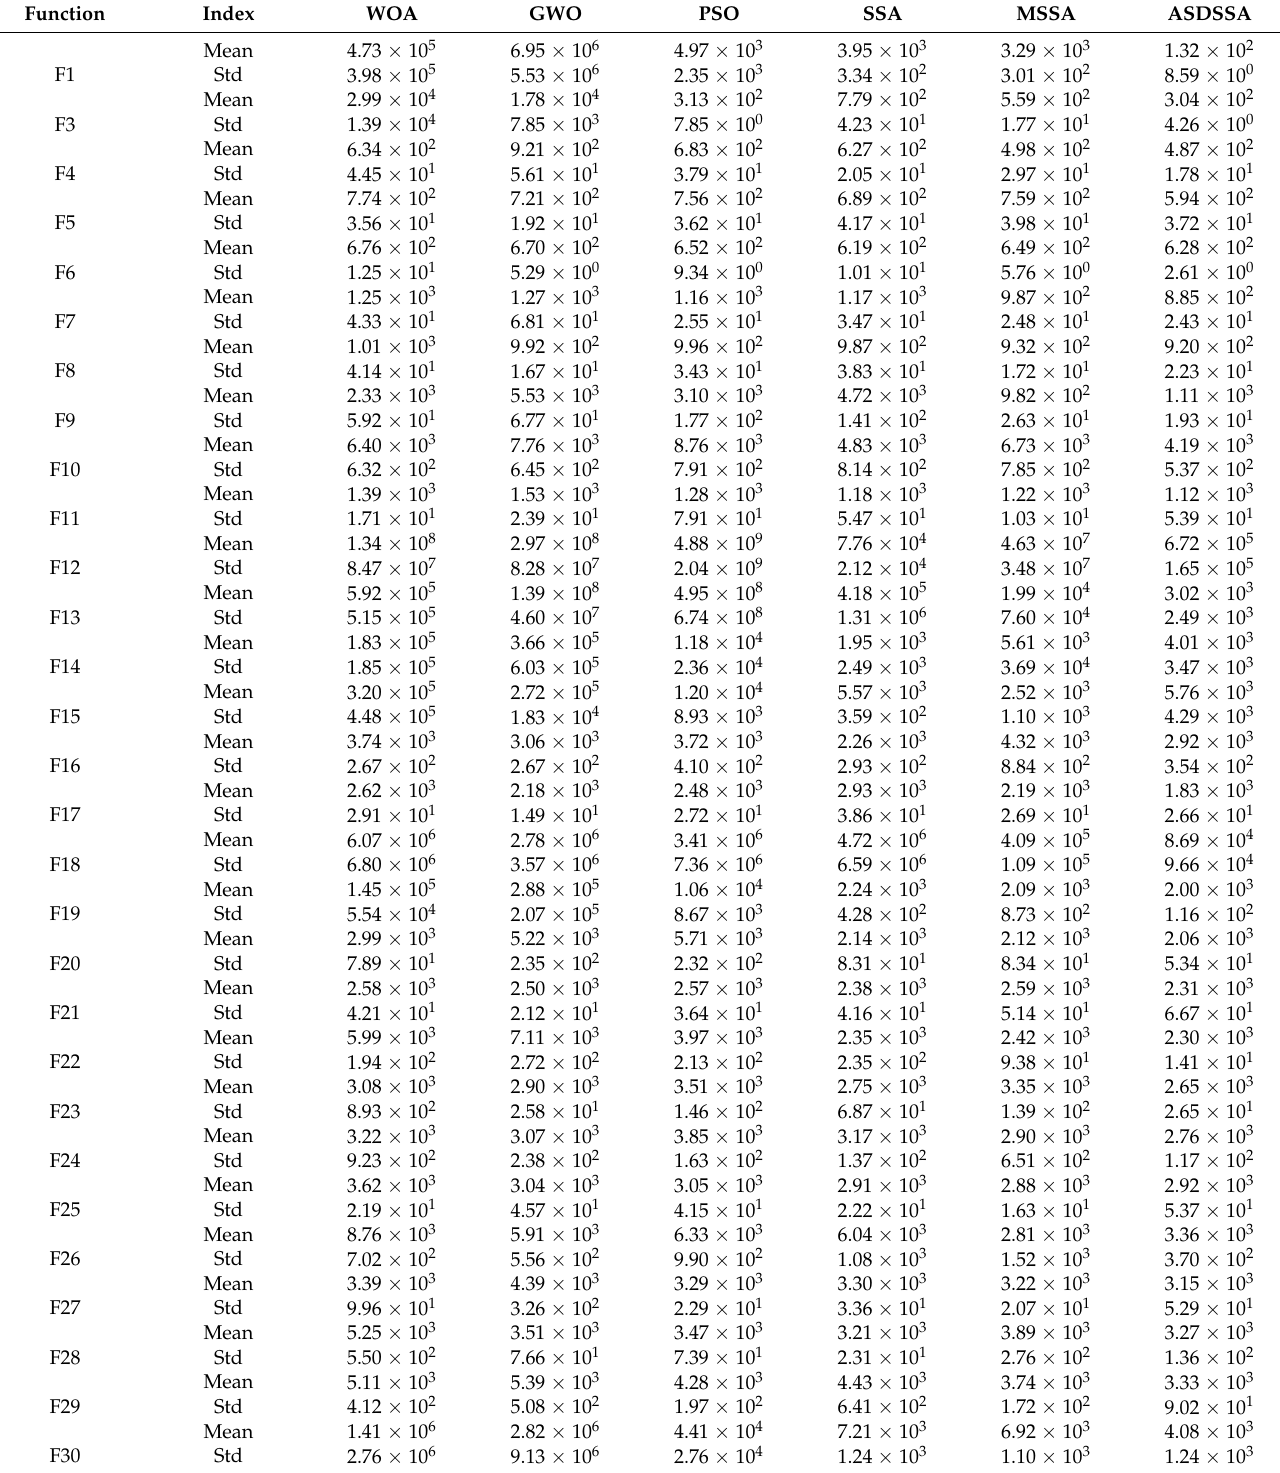
Table 5. CEC2017 test